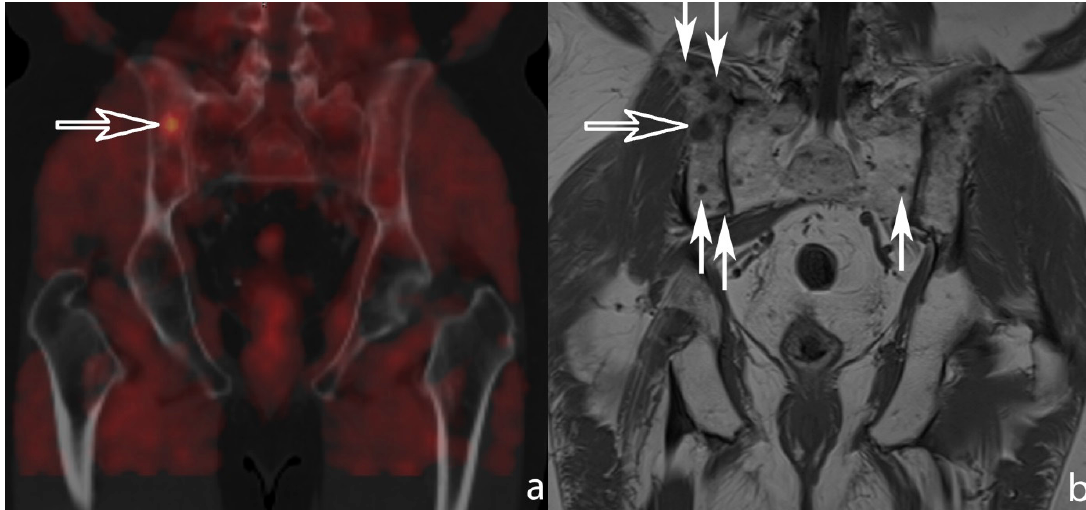
Figure 1. ( a ) Coronally reformatted fused choline positron emission tomography/computed tomography (PET/CT) image (left) and ( b ) 5 mm coronal T1-weighted magnetic resonance